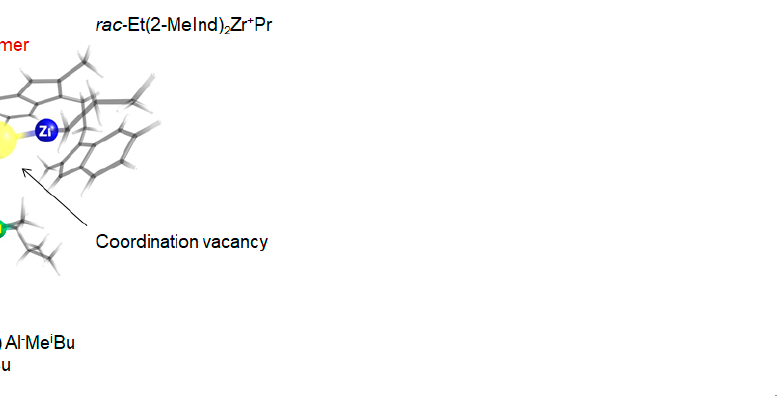
Figure 2. DFT optimized structure of catalytically active center rac -Et(2-MeInd) 2 Zr + Pr . . . (2,6- t Bu 2 -4-R-PhO-)Al – Me i Bu, where R is para -substituent in the aryloxy fragment.